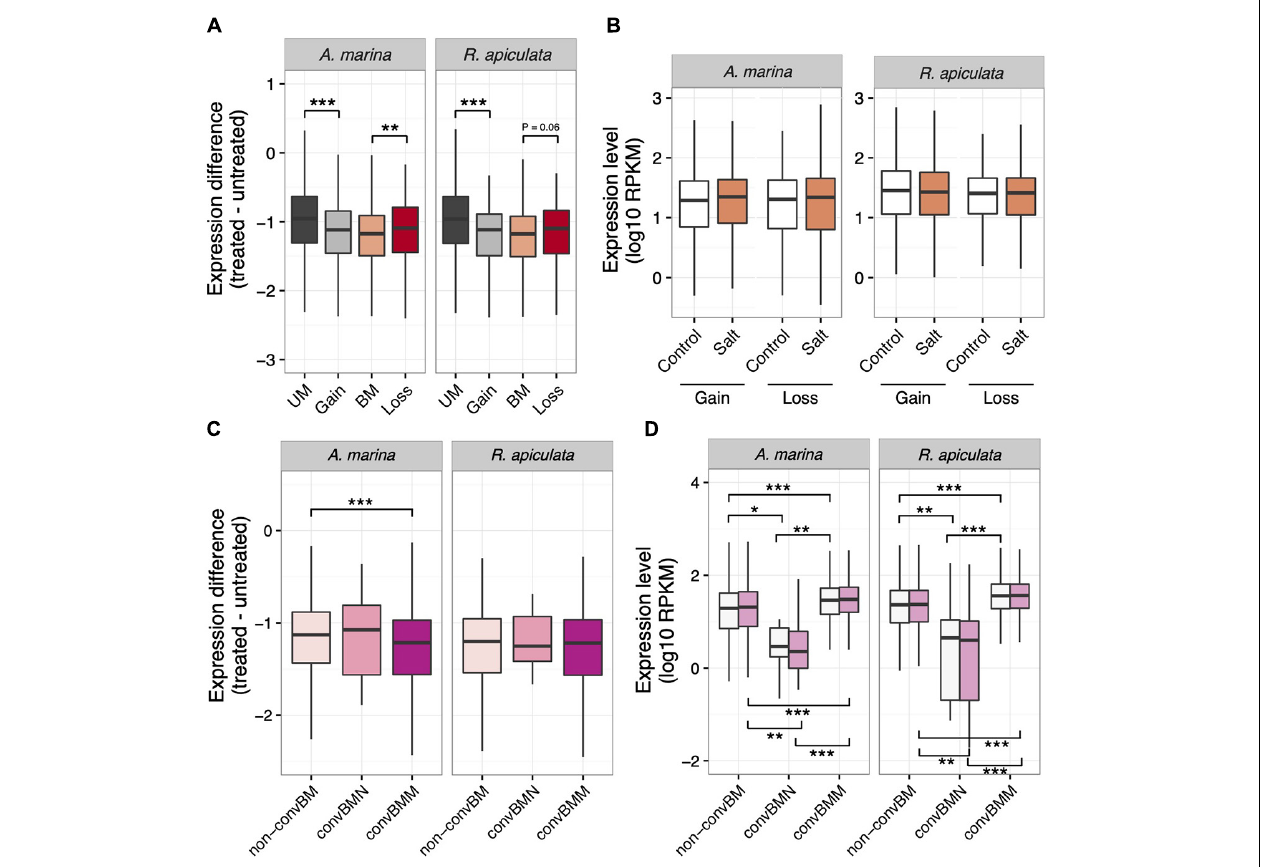
FIGURE 5 | Expression patterns in relation to gbM status in A. marina and R. apiculata under salt stress. (A) Absolute expression difference of genes that gained or lost gbM in response to salt stress. (B) Expression level of genes that gained or lost gbM in response to salt stress. (C) Salt-responsive absolute expression differences in relation to gbM convergence. (D) Expression levels in relation to gbM convergence in salt-treated (pink) and control samples (white). BM, CG body-methylated genes; UM, unmethylated genes. convBMM, BM genes with convergence of gbM specific to mangroves; convBMN, BM genes with convergence of gbM specific to non-mangroves; non-convBM, BM genes with gbM conserved in two or three species but not convergently evolved in either mangroves or non-mangroves. Significance was determined by the Mann–Whitney U test: * P < 0.05, ** P < 0.01, *** P < 0.001. The middle bars in the boxes represent the median; the top and bottom of the boxes indicate interquartile ranges, and whiskers denote the